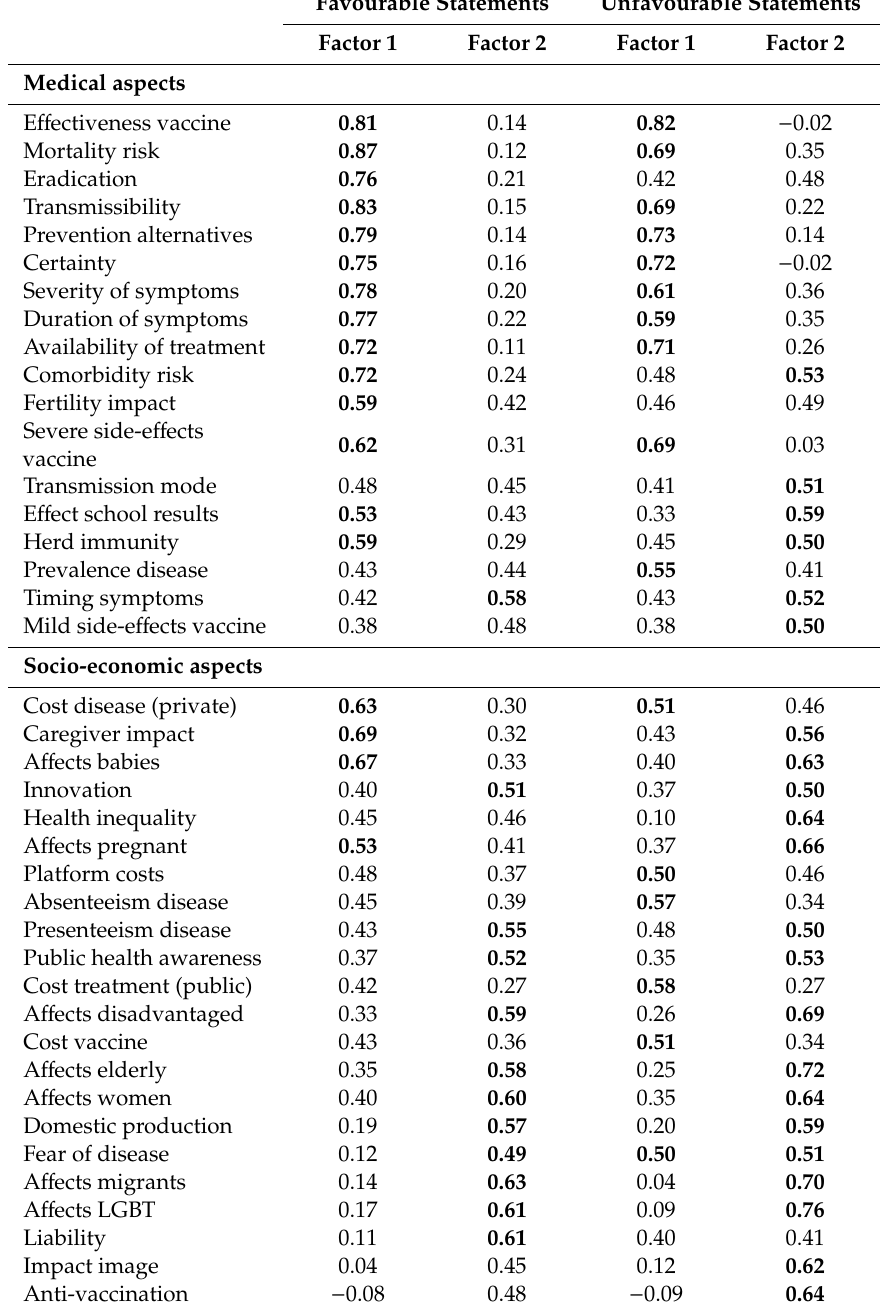
Table 4. Factor loadings from a factor analysis on the respondent scores for the favourable and unfavourable